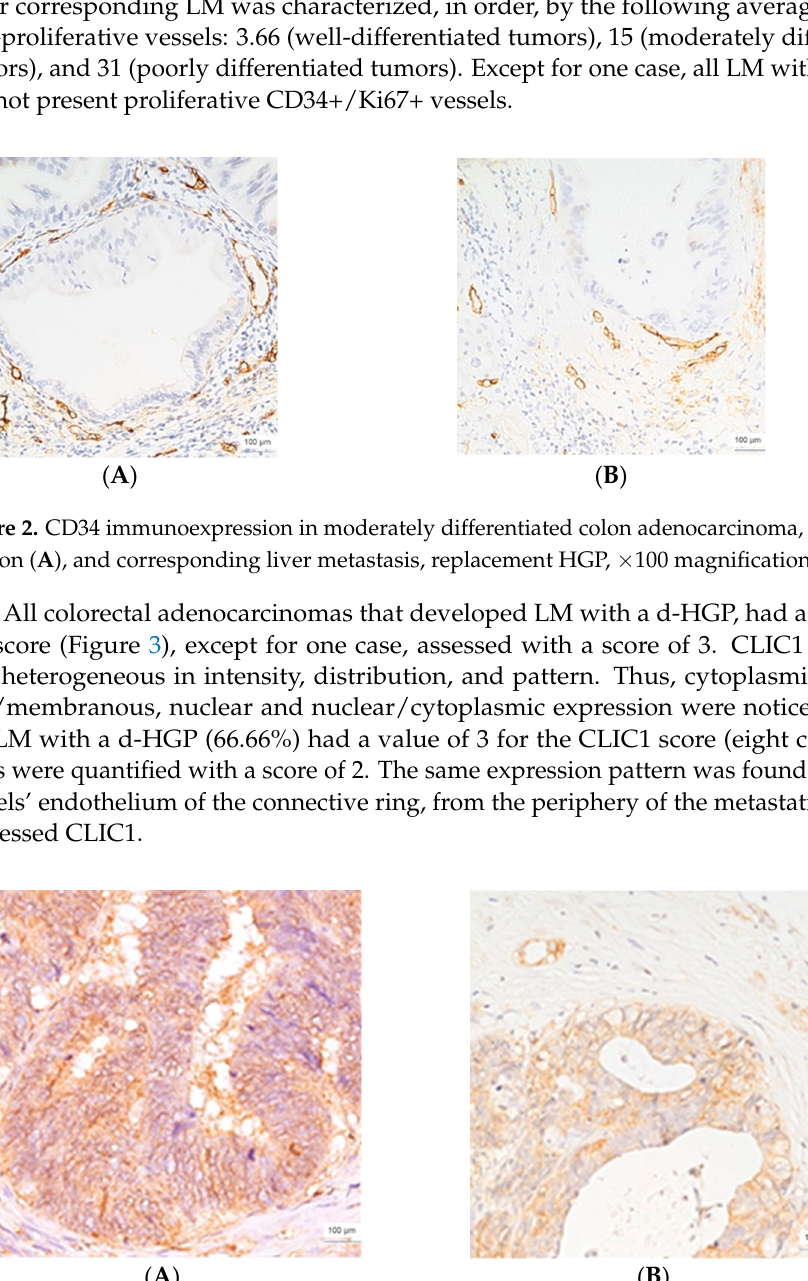
( C ) Figure 1. CD 34 immunoexpression, poorly differentiated colon adenocarcinomas, intratumoral vessels, ×200 magnification ( A , B ), and corresponding metastasis (p ‐ HGP), ×200 magnification ( C ). All seven cases of pancreatic adenocarcinomas evaluated in the present study de ‐